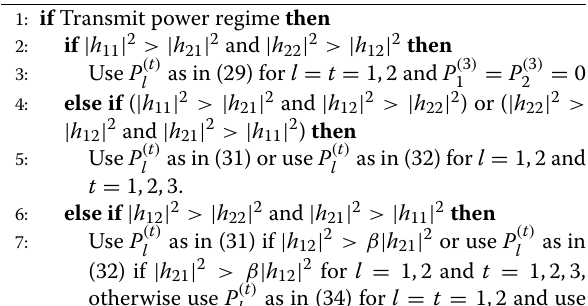
Algorithm 1 DRCP power